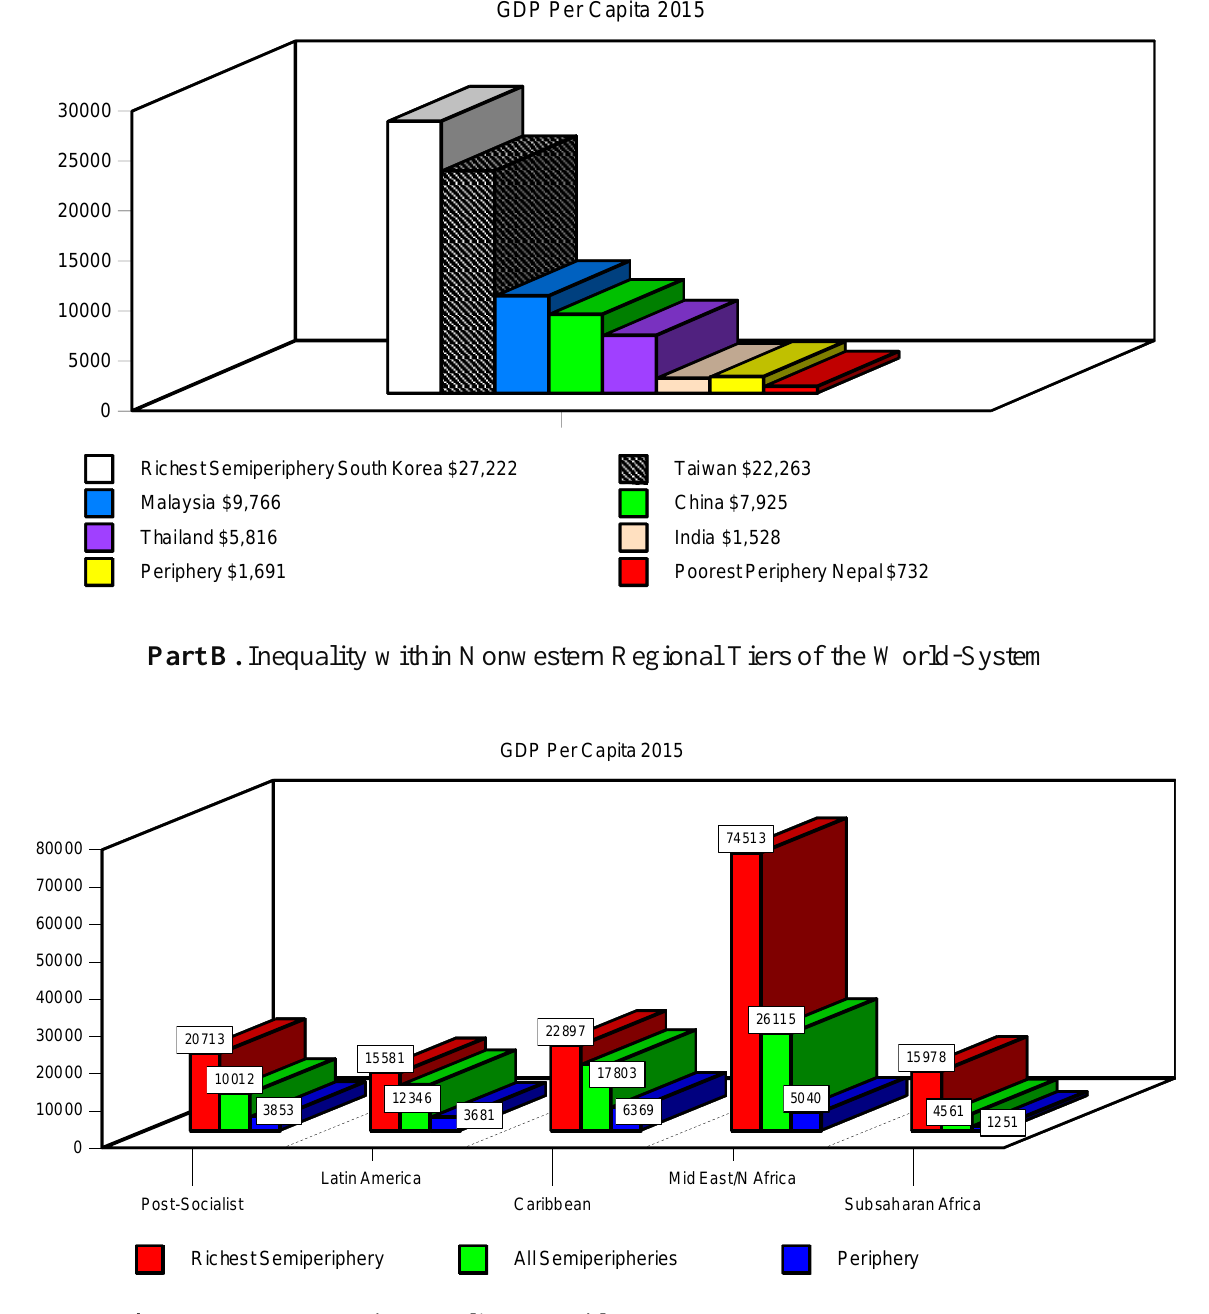
Figure 3. Inequality between Tiers of the World-System, 2015 Part A . Inequality within the Asian Subregion